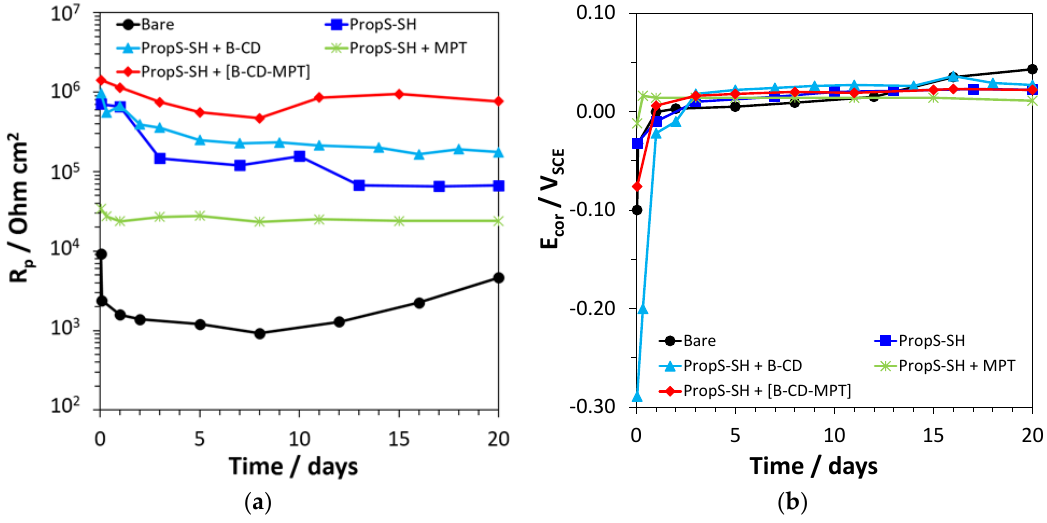
Figure 8. Polarization resistance ( R p ) ( a ) and corrosion potentials ( E cor ) values ( b ) measured during 20 days of immersion of bare and coated bronze electrodes in concentrated acid rain (ARX10) at 30 °C.